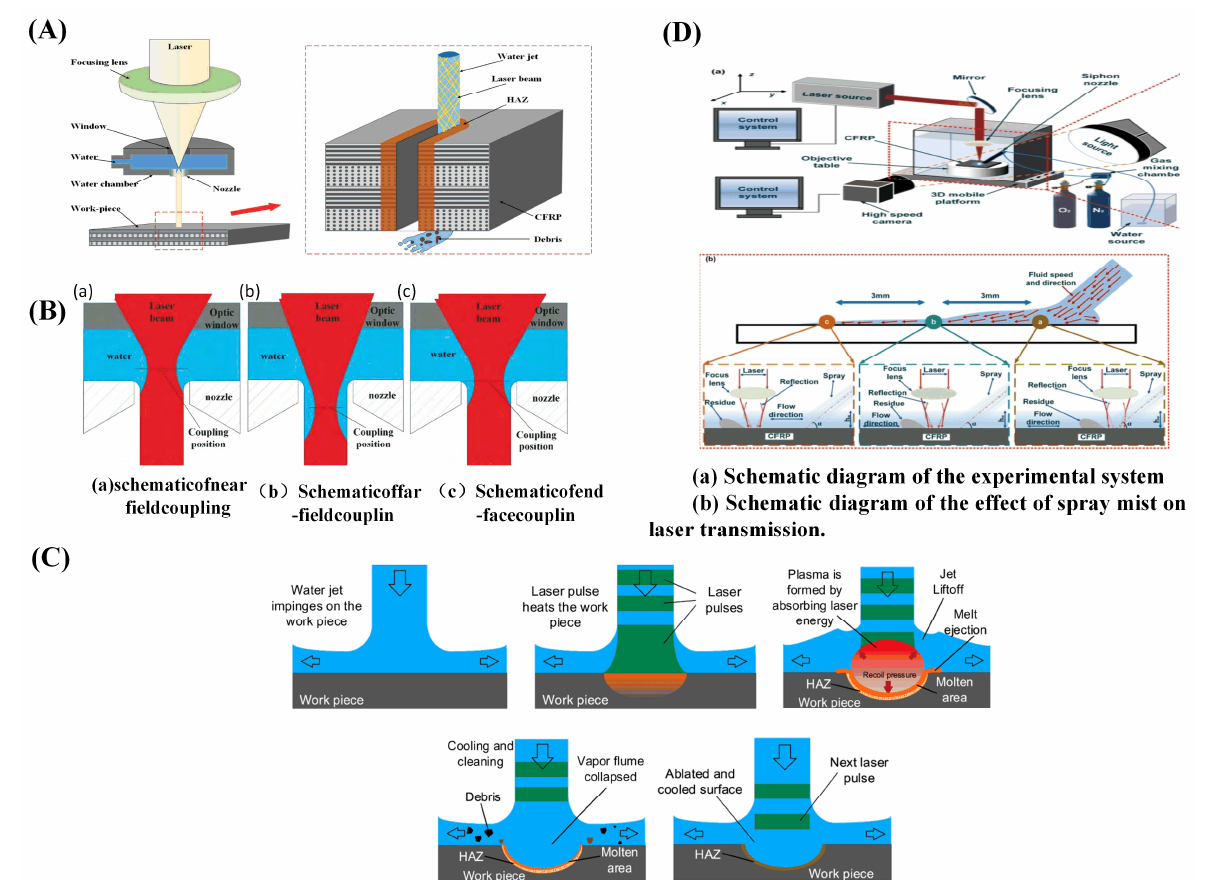
Figure 16. Liquid-assisted laser processing CFRP method and water-guided laser processing CFRP technology principle: ( A ) schematic for cuing CFRP with a laser guided by a water jet [106]; ( B